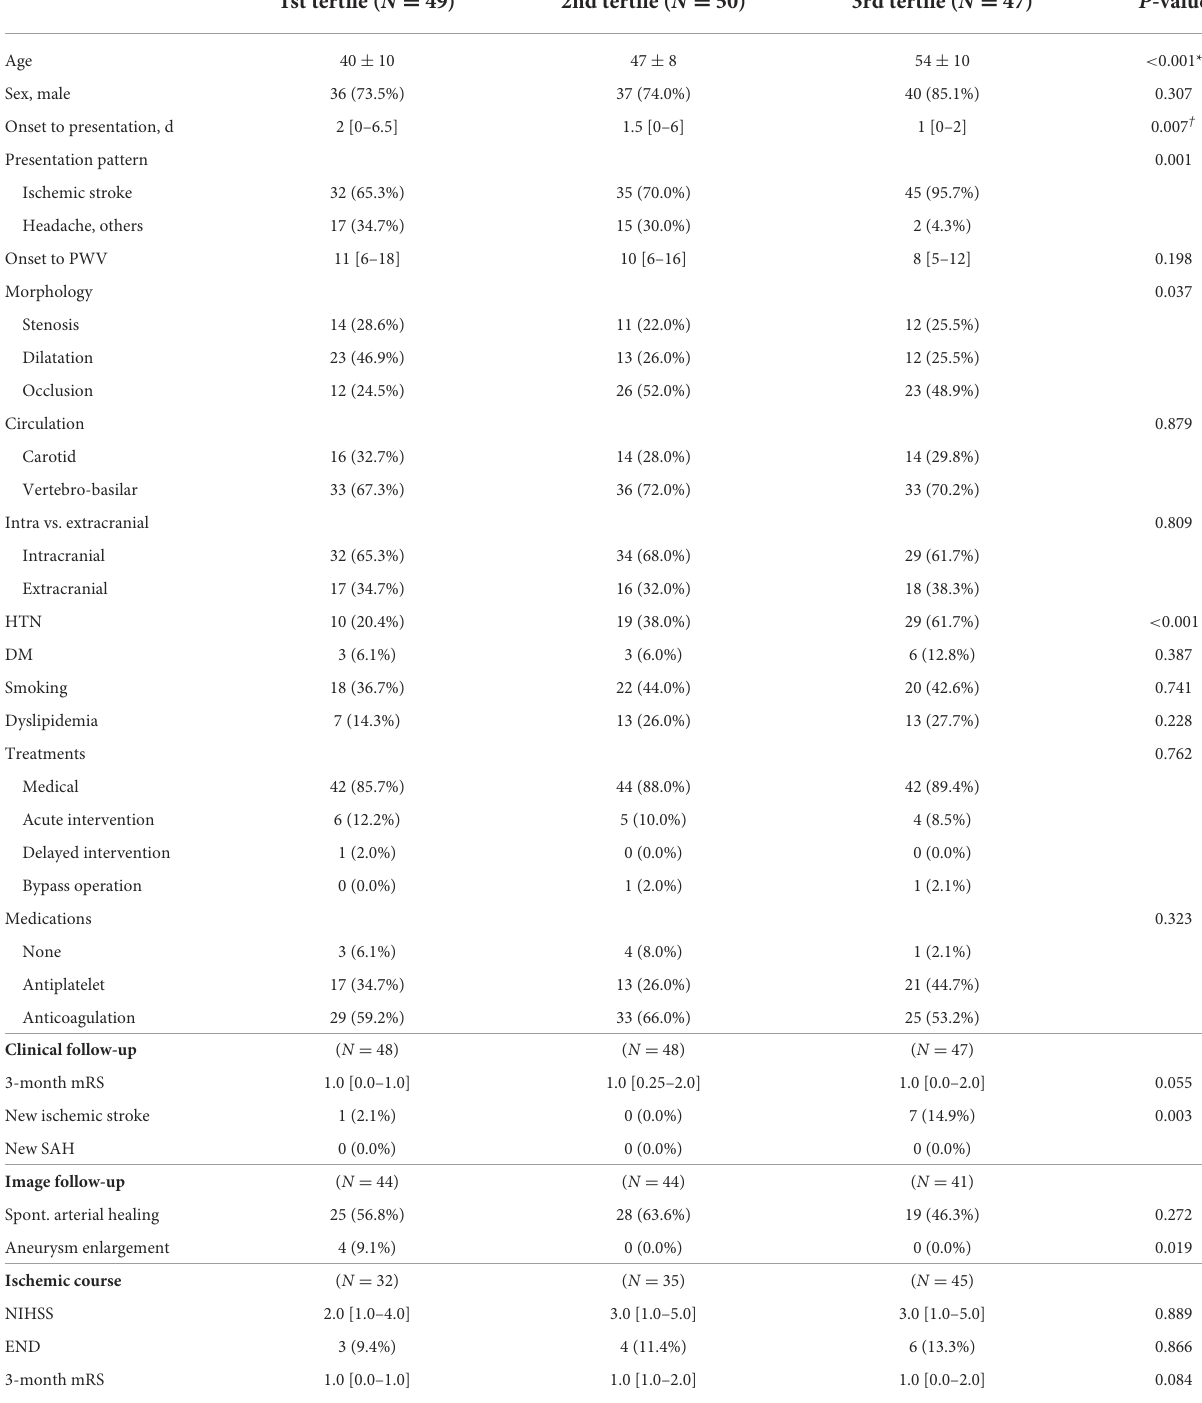
TABLE 3 Baseline profiles, treatment, clinical, and imaging characteristics according to the tertiles of pulse wave velocity